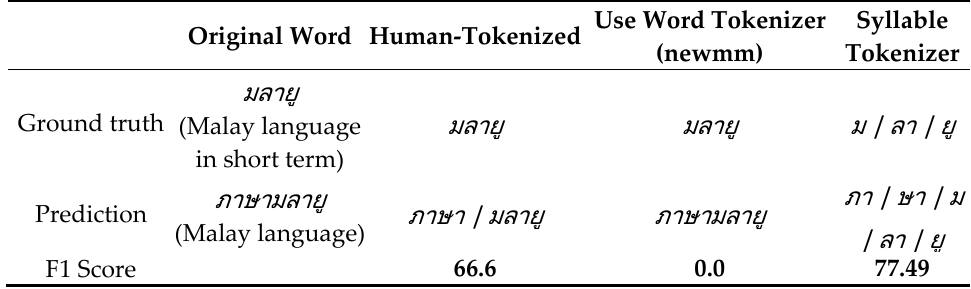
Table 2. Example of tokenization used in this work.